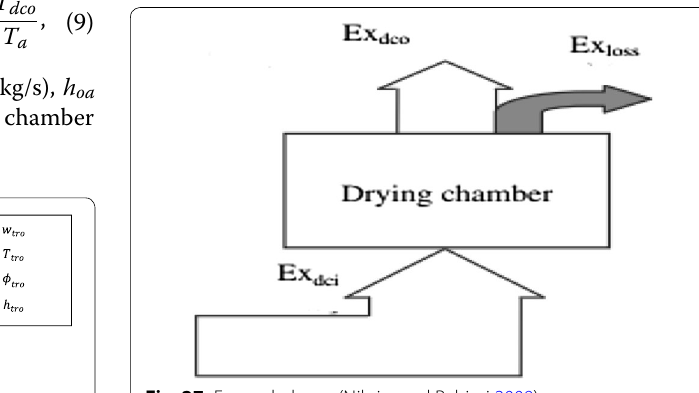
Fig. 26 Schematic illustration of the tray Fig. 27 Exergy balance (Niksiar and Rahimi